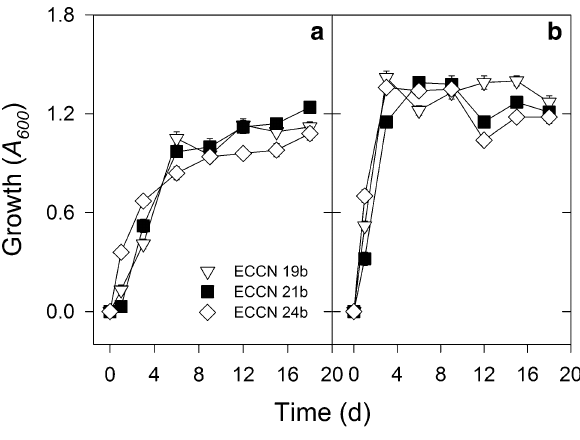
Fig. 1 Growth response of Citrobacter strain ECCN 19b, Exiguobac- terium strain ECCN 21b, and Serratia strain ECCN 24b in